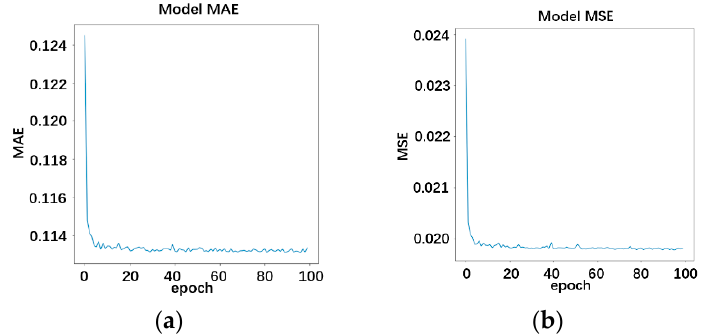
Figure 7. Model training error of 50% road quantity: ( a ) model MAE; ( b ) model MSE.